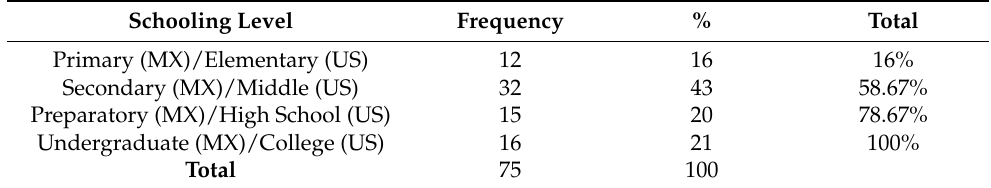
Table 6. Cumulative frequency of schooling.